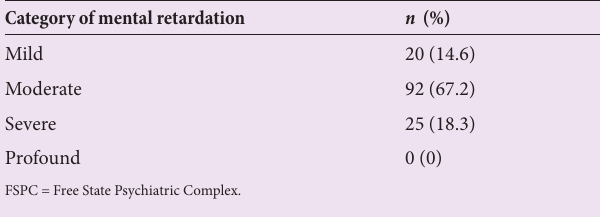
Table 3. Category of mental retardation of rape victims evaluated at the FSPC, 2003 - 2009 ( N =137)